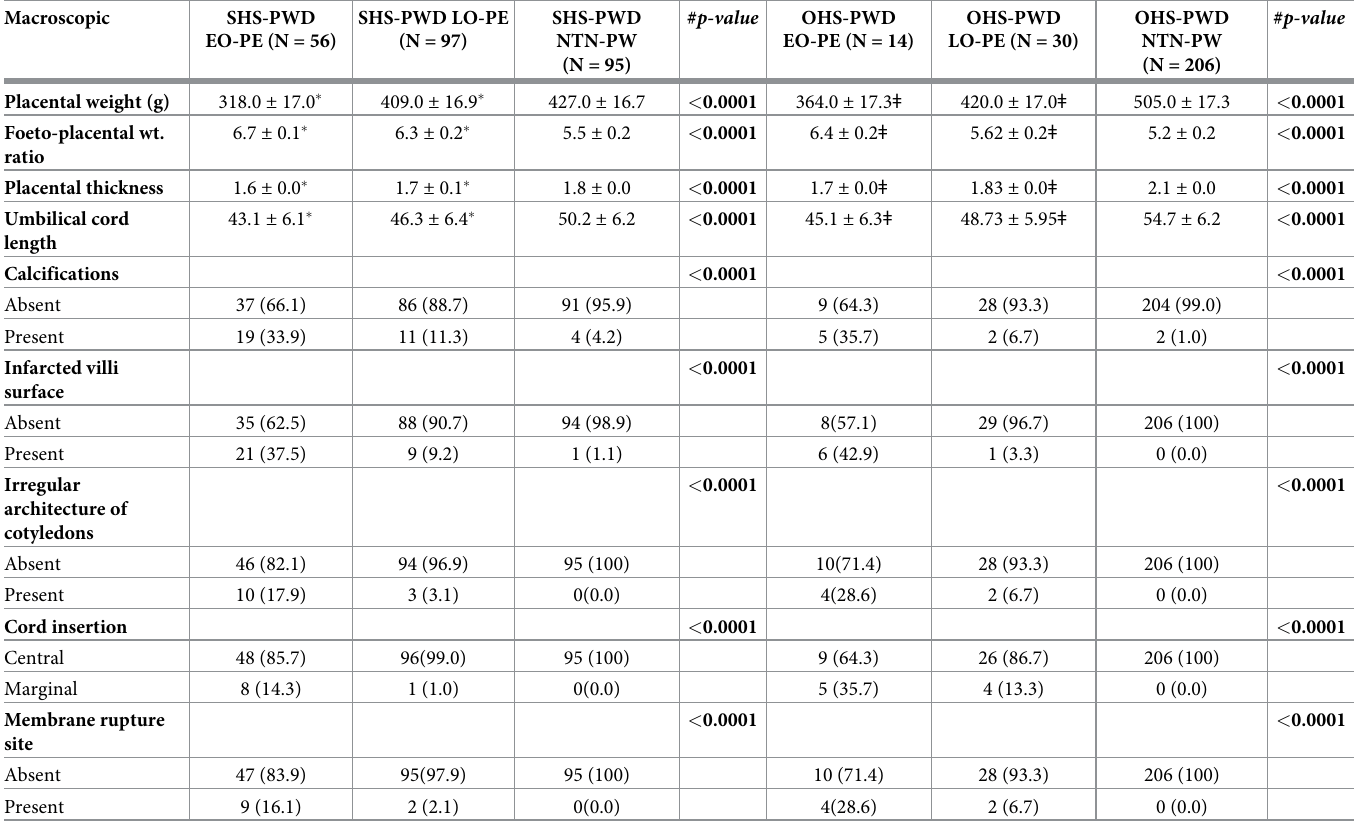
Table 3. Gross morphology of the placentae among the SHS and OHS-PWD EO-PE and LO-PE compared to NTN-P.